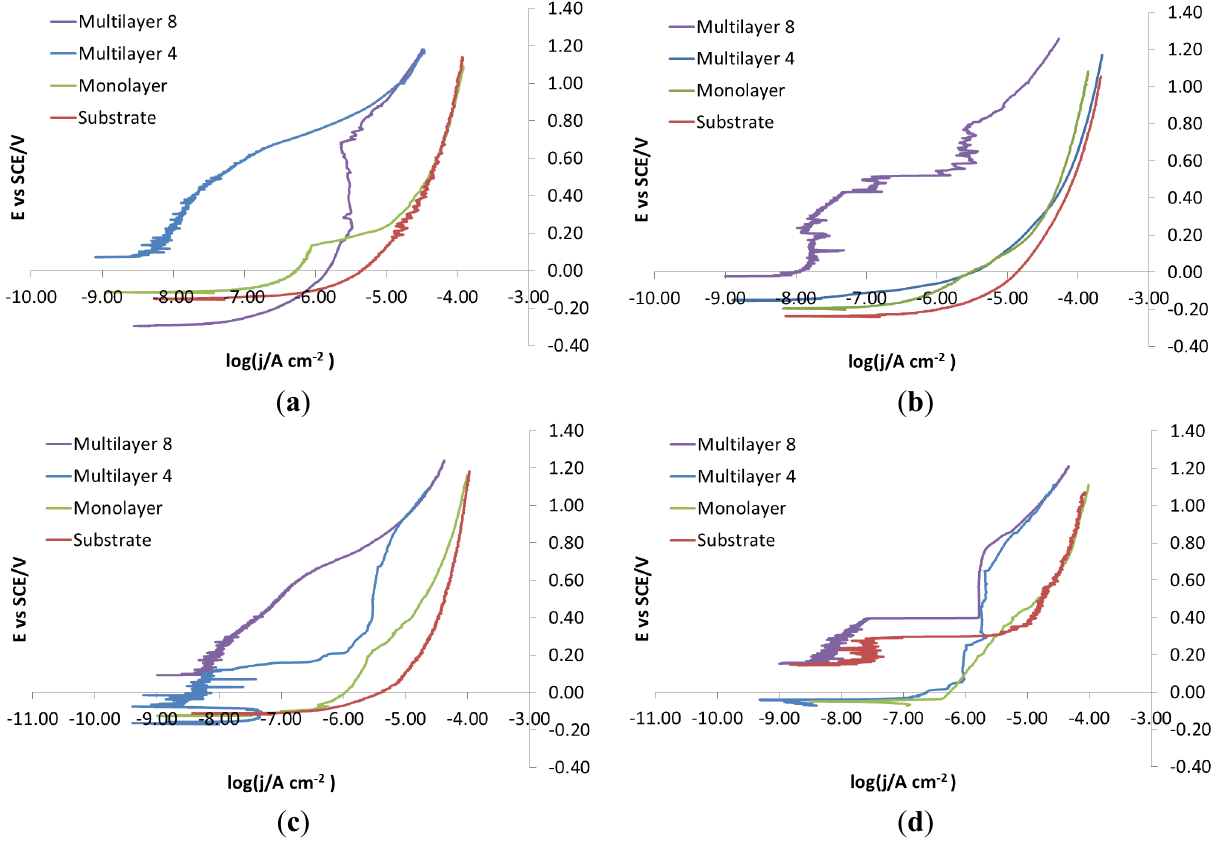
Figure 12. Electro-eroded finish: polarization curves on bare and coated steels.